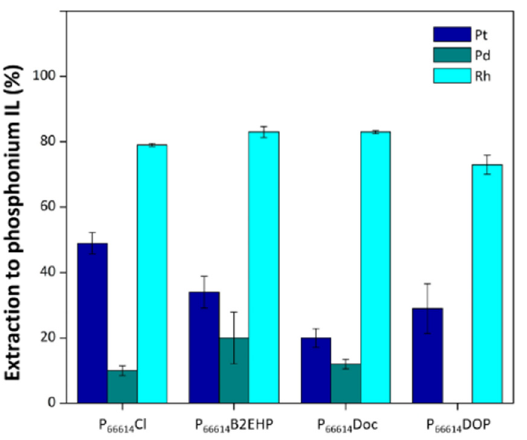
Figure 2. Extraction efficiencies (%) of PGMs from PGM model solution with different phosphonium-based ILs.